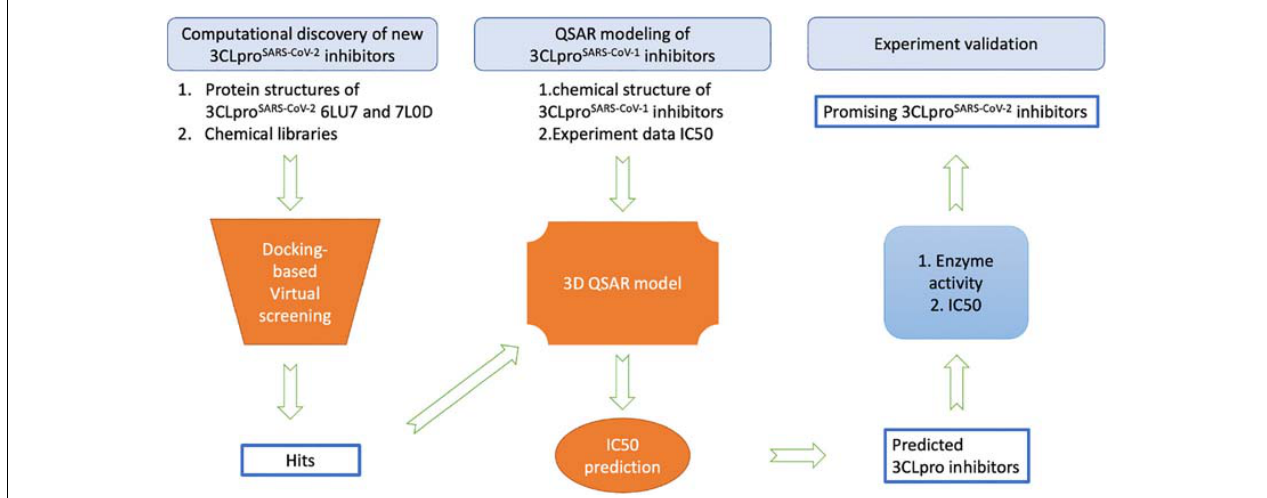
FIGURE 1 | The overview of the proposed workflow to discover new inhibitors of 3CLpro SARS - CoV - 2 .